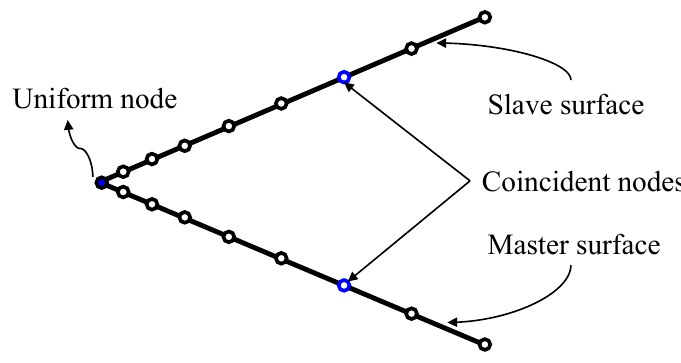
Figure 4. Crack modeling with a surface-to-surface contact method.